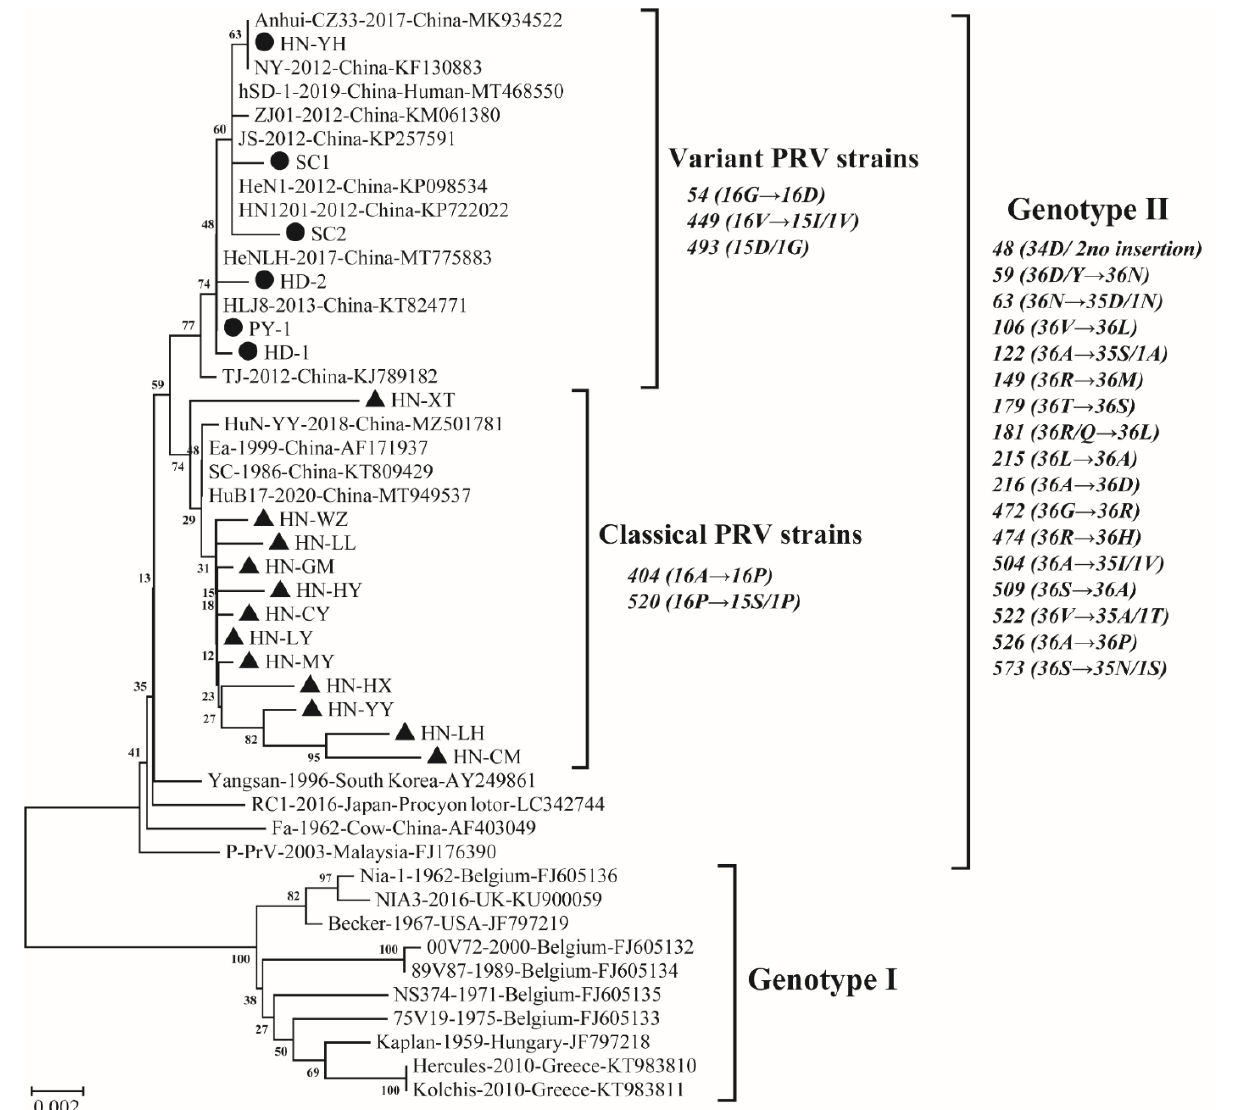
Figure 3. Phylogenetic tree based on the nucleotide sequences of gE gene of 18 PRV isolates deter- mined in this study and 28 reference strains. Neighbor-joining trees were constructed with p-distance model and bootstrapping at 1000 replicates. Black solid circles ( ● ) and black solid triangles ( ▲ ) represent variant strains and classical strains in this study, respectively.